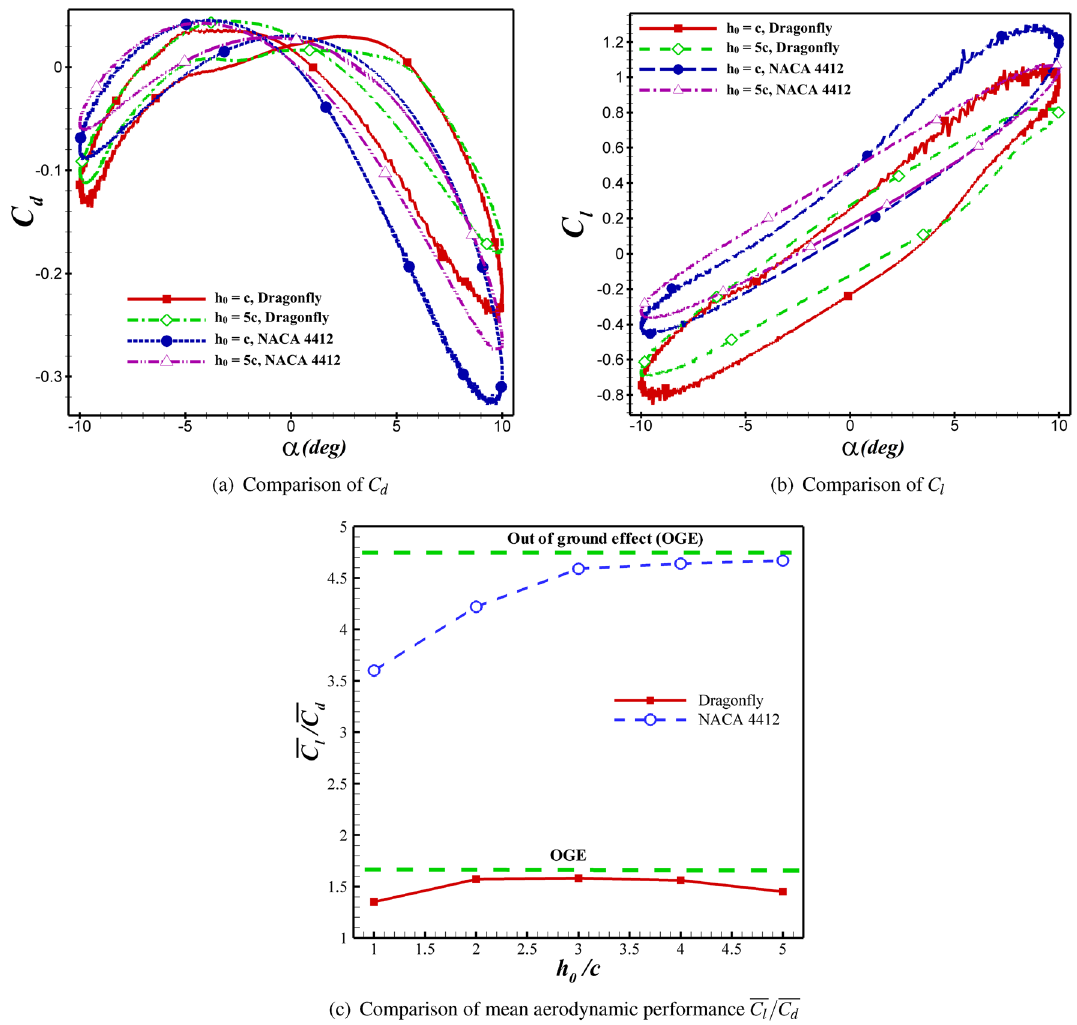
Figure 13. Comparison of C d , C l and C l / C d between dragonfly and NACA 4412 airfoils in different distant from the ground at St = 0.4 and Re = 5 × 10